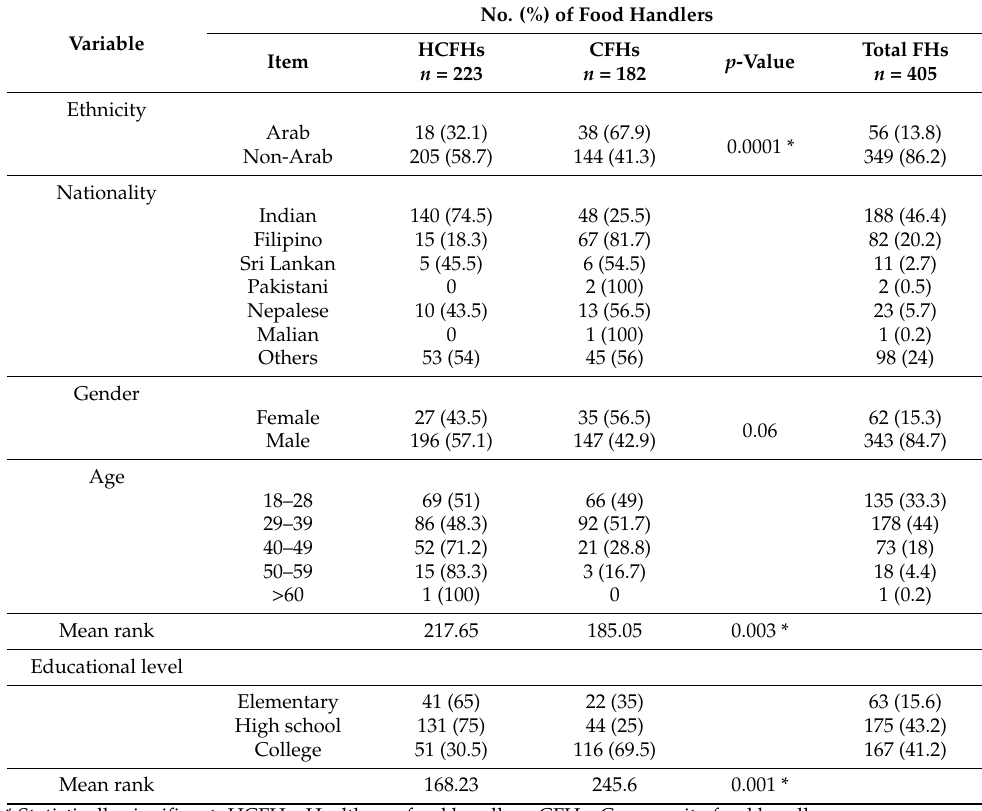
Table 1. Demographic characteristics of healthcare and community food handlers.